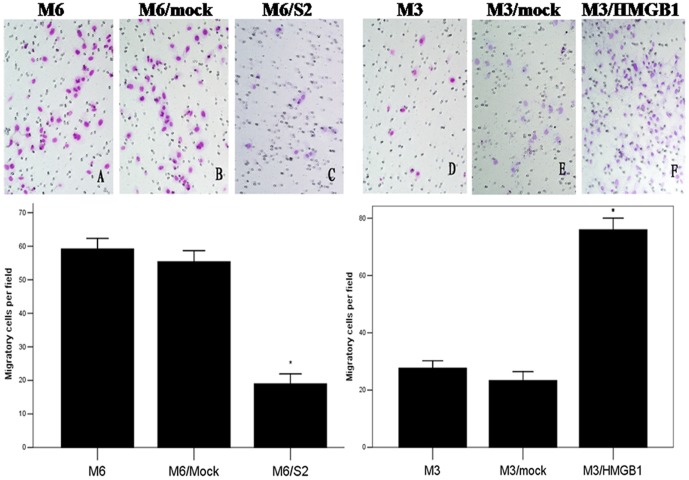
Cell migration assay.The number of cells that passed through cell chamber in HCCLM6/S2 group was less than in two other groups. However, the number of cells that passed through cell chamber in HCCLM3/HMGB1+ group was more than in two other groups. All the results were represented as the mean ± SD from three independent experiments. *p<0.05 (compared with both parental and mock groups). Migrating cells were stained with Giemsa and visualized by microscopy (original magnification ×200).